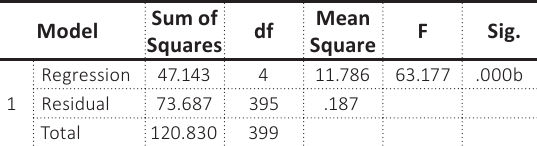
Table 7. Analysis of variance for H2 (ANOVA)